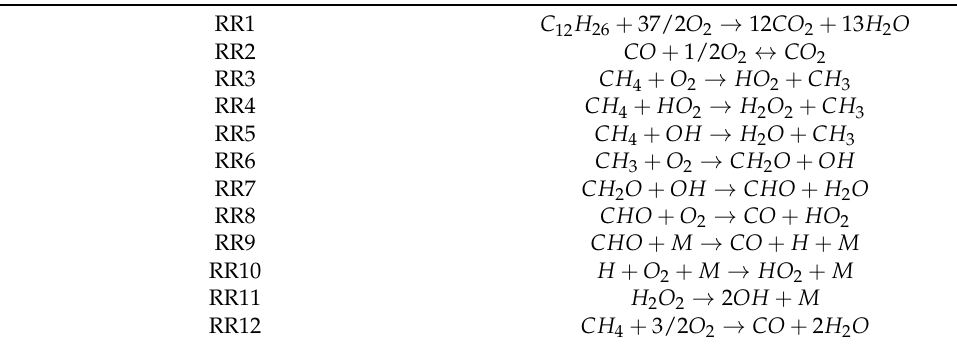
Table 3. Reaction